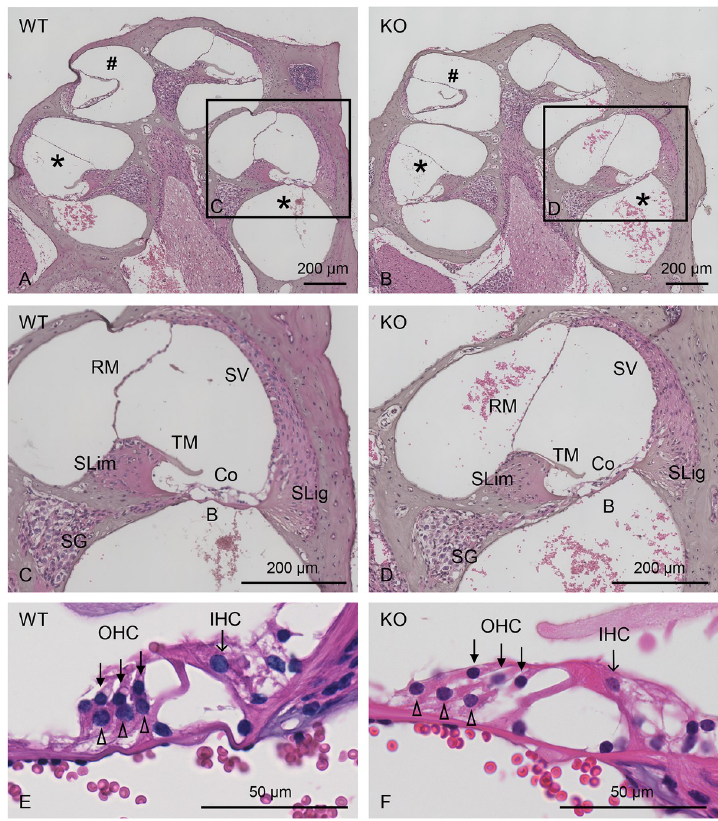
Fig 6. Representative images of HE-stained midmodiolar cochlear sections. Histological comparison between WT (A, C, E) and Col4a6 KO (B, D, F) mice. (C-F) Images with higher magnification of cochlear basal turn are shown. No differences are observed between WT and Col4a6 KO mice. , basal turn; #, apical turn; SG, spiral ganglion; SLim, spiral limbus; TM, tectorial membrane; B, Basilar membrane; Co, organ of Corti; SLig, spiral ligament; SV, stria vascularis; RM, Reissner’s membrane; closed arrows, OHC (outer hair cells); arrows, IHC (inner hair cells); open arrowheads, Dieter’s cells.